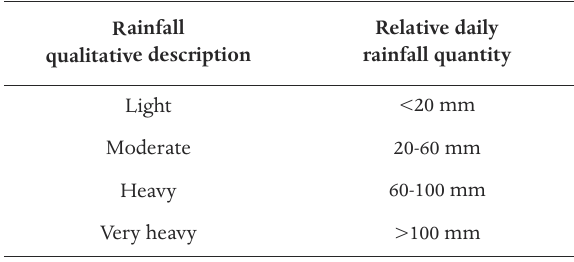
Table 3. Rainfall qualitative description versus the corresponding daily rainfall quantity.